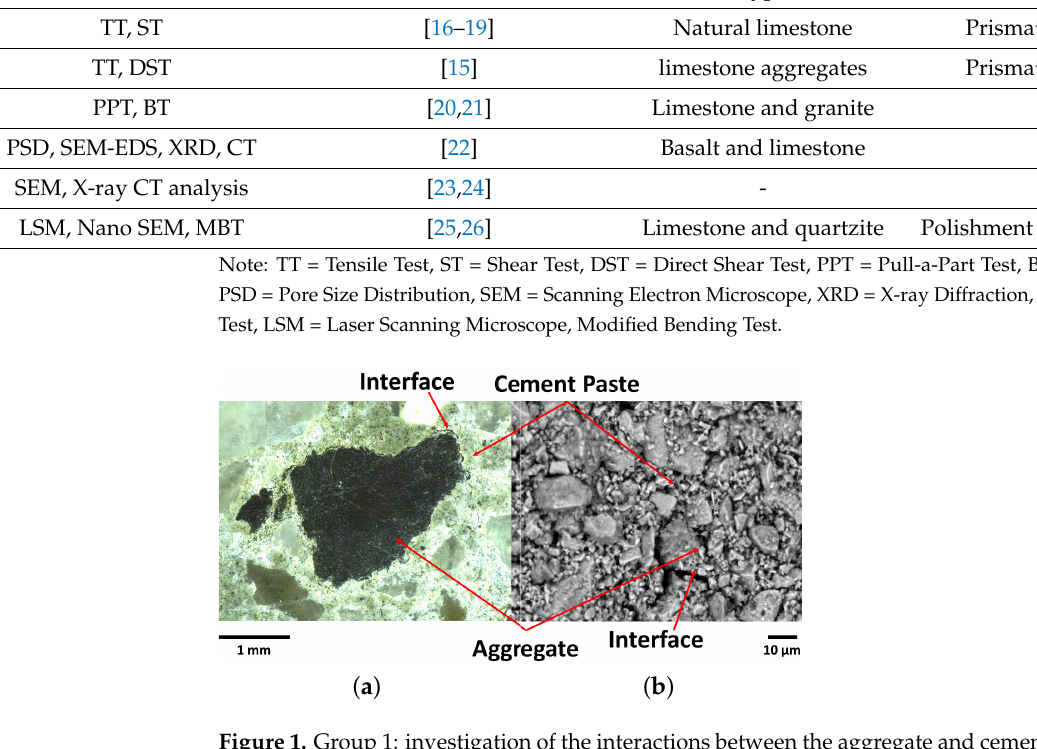
Figure 1. Group 1: investigation of the interactions between the aggregate and cement-based matrices by image analyzes: zommed-in views for ( a ) macaúba endocarp and ( b ) river sand embedded in cement